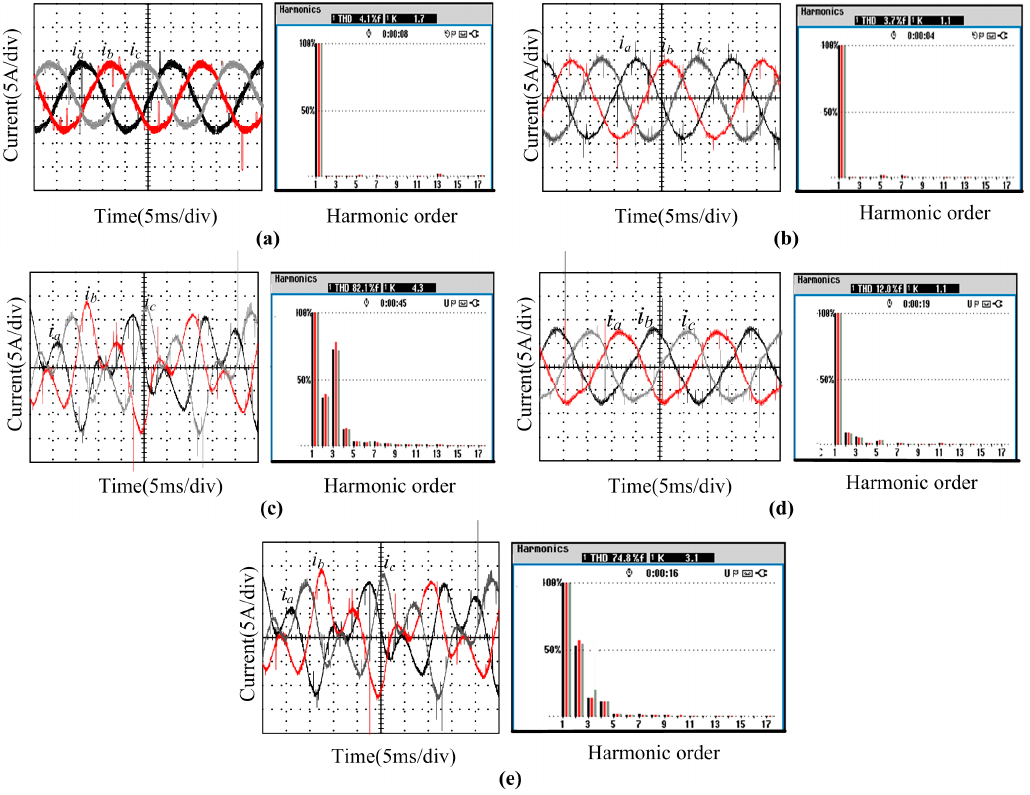
14 of 16 Figure 18. Grid-connected currents comparison under different current sampling schemes with varied grid impedance. ( a ) Grid-connected currents under IC sampling with L g = 4 mH; ( b ) Grid-connected currents under GC sampling with L g = 4 mH; ( c ) Grid-connected currents under IC sampling with L g = 6 mH; ( d ) Grid-connected currents under GC sampling with L g = 6 mH. Figure 19 depicts the stability comparison with GC sampling under different current reference